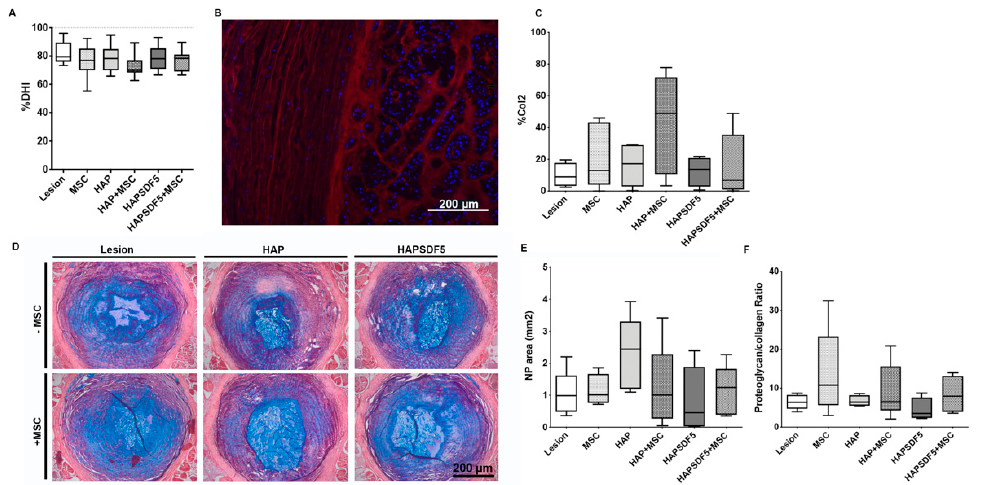
Figure 4. IVD radiological and histopathological analysis 2 weeks post-injury and intradiscal ad- ministrations. ( A ) Percentage of disc height index (%DHI) quantified from X-ray images. ( B ) Immunohistochemistry for collagen type II (Col II: red; DAPI for cell nuclei: blue, scale bar 200 µm) and ( C ) respective quantification. ( D ) Representative sections of alcian blue/picrosirius red staining (proteoglycans in blue, collagen in red) for groups lesion, lesion+MSC, HAP, HAP+MSC, HAPSDF5, and HAPSDF5+MSC (scale bar 200 µm); ( E ) quantification of the NP area (mm 2 ); ( F ) quantification of the proteoglycans/collagen content ratio in the NP.